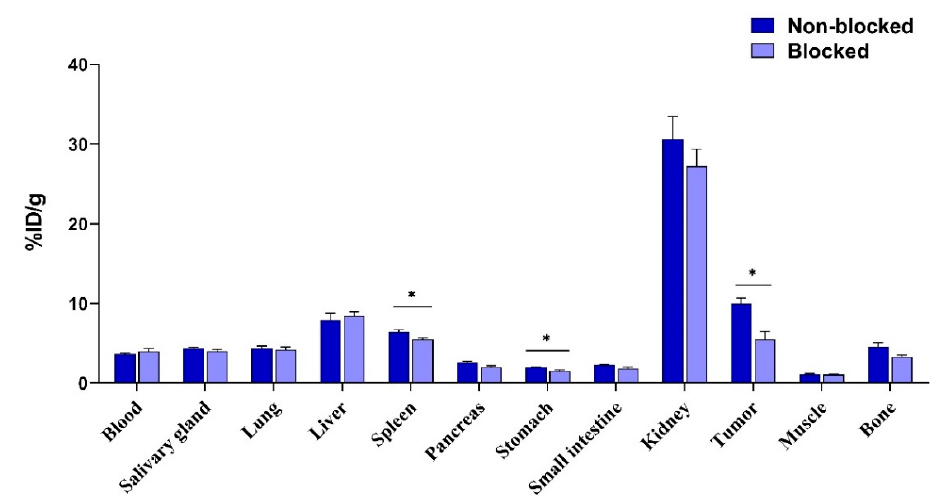
Figure 6. In vivo targeting specificity at 72 h pi. The error bars represent the standard deviation. * indicates a significant difference with a P value < 0.05.